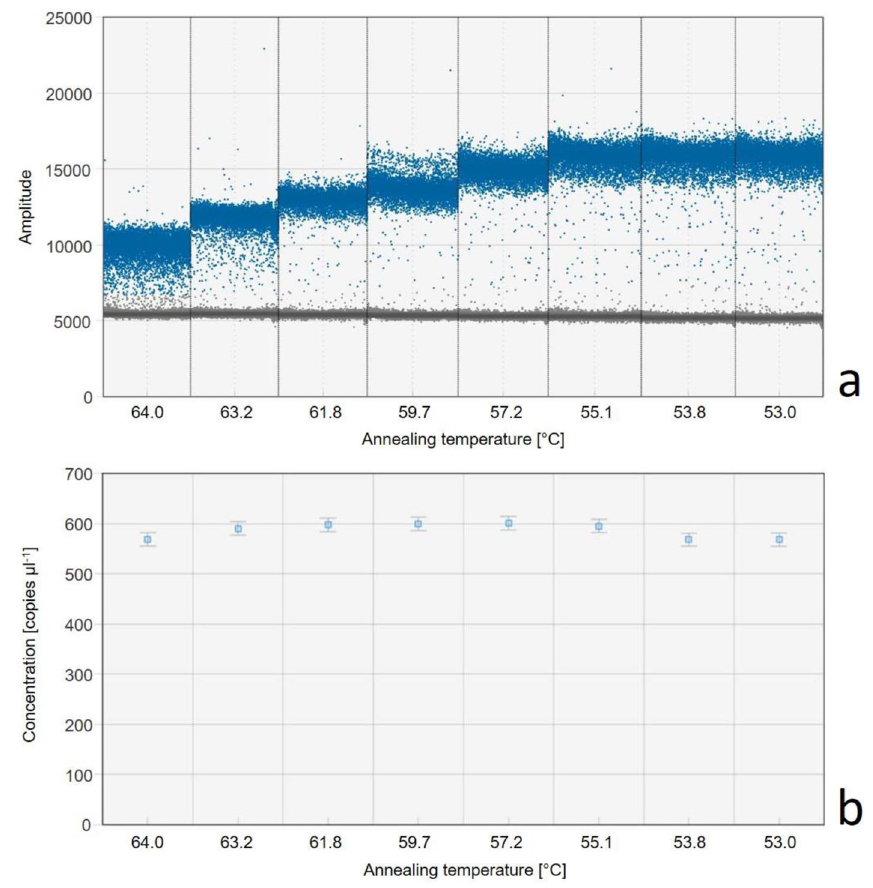
Figure 1. DdPCR thermal gradient experiment with a rainwater tank sample and the newly designed primer set ComaA1A2_336F/497R. ( a ) Shows the fluorescence amplitude plotted against the annealing temperature gradient. Positive droplets with PCR products are indicated in blue, negative droplets without any amplification are outlined grey. ( b ) Shows the corresponding concentrations along the temperature gradient, the error bars indicate 95% Poisson confidence